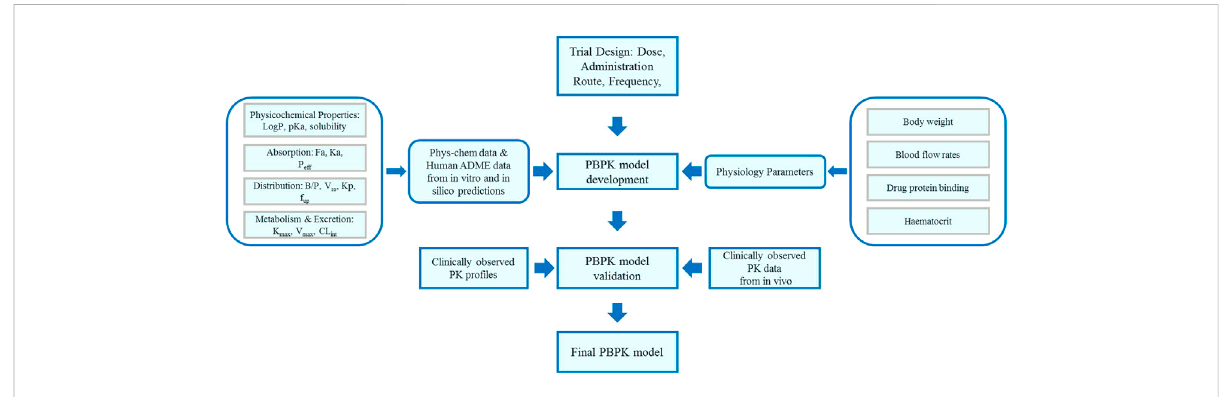
FIGURE 1 A basic framework of PBPK model development and DDI simulation.